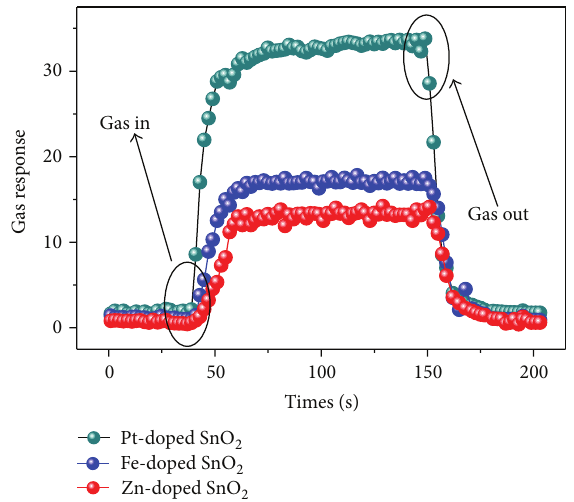
Figure 8: Selectivity of the 2 at% Pt-, Fe-, and Zn-doped SnO 2 sensors to 100ppm of various gases at 300 ∘